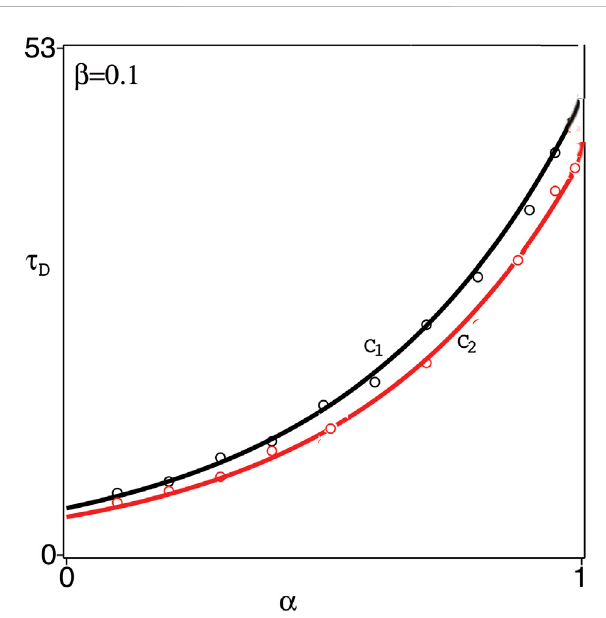
FIGURE 3 Time-delay, τ D , versus the fractional derivative parameter α at fi xed β =0.1. Circles represent the numerical results and the solid lines C represent the exponential fi tting, 4.9 e 2.2 α in the case of Caputo ’ s derivative, and 3.8 e 2.3 α in the case of Caputo-Fabrizio ’ s derivative,